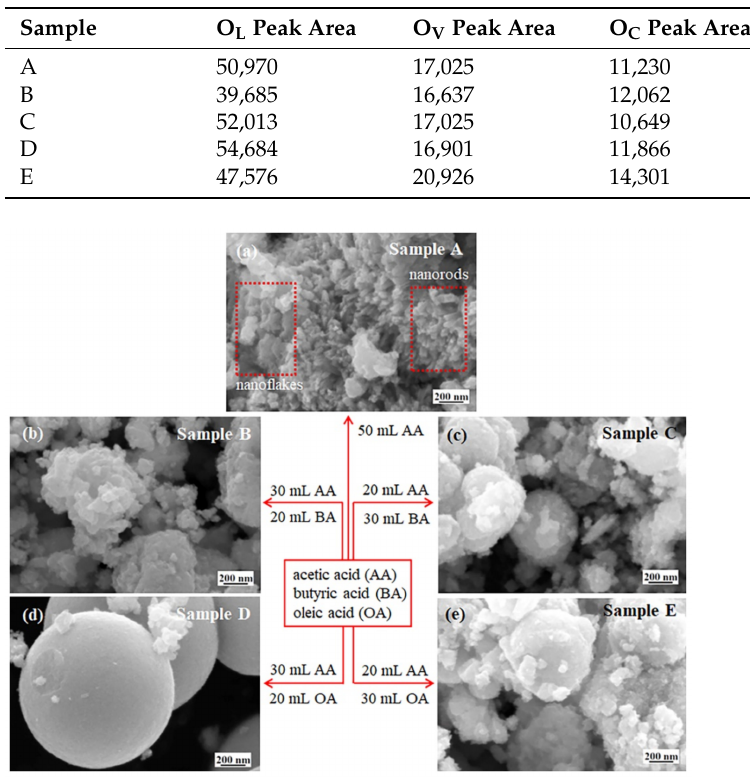
Table 5. Areas of O L , O V and O C peaks and the area ratio R of O V peak to the area sum of O L and O V peaks.